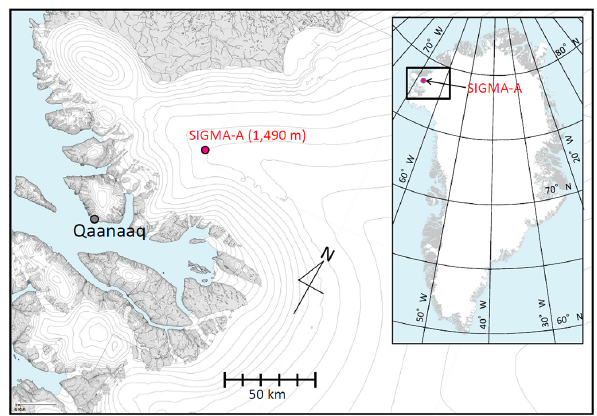
Figure 1. The location of site SIGMA-A together with ice sheet surface elevation contours (ma.s.l.). Height interval is